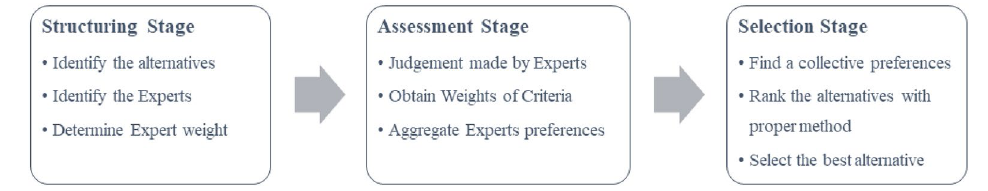
Figure 3. General MADM evaluation